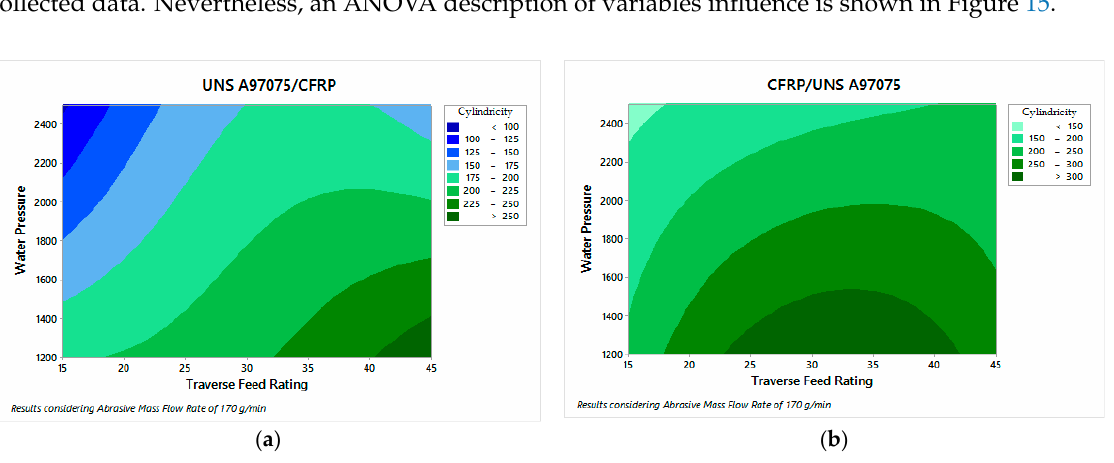
Figure 15. Cylindricity results on: ( a ) UNS A97075/CFRP configuration; ( b ) CFRP/UNS A97075 configuration.